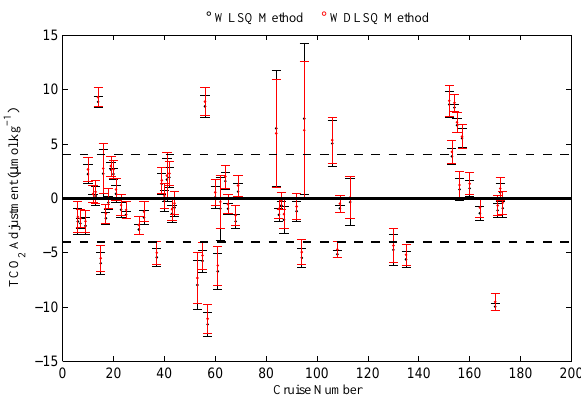
Figure 4. Adjustment values (dots) and their respective standard deviation (vertical bars) obtained from the two inversion methods used as a function of cruise number (see Table 1). Black dots were obtained with the WLSQ method; red dots were obtained with the WDLSQ method. An explanation of the di ff erence between the two methods is provided in the text.